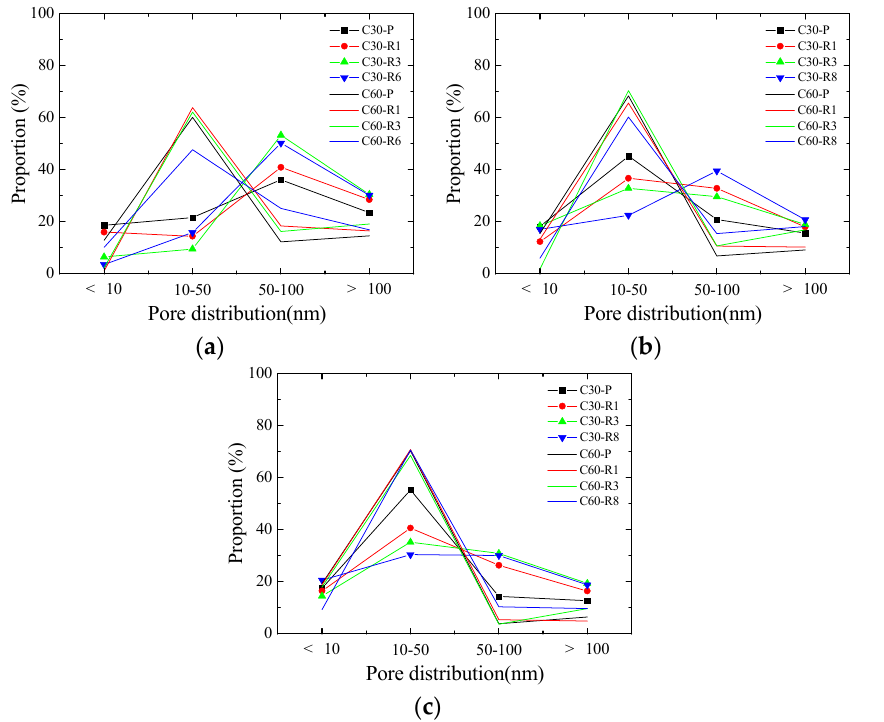
Figure 6. Comparison of pore size distribution between C30 specimen and C60 specimen at three ages: ( a ) 3 d; ( b ) 7 d; ( c ) 28 d.